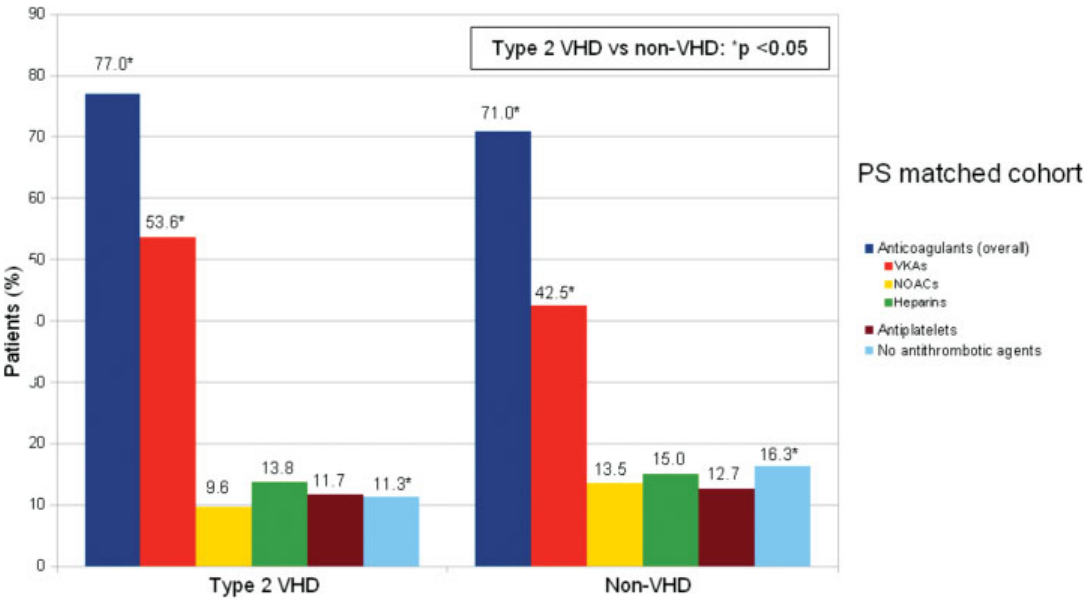
Fig. 4 Treatment distribution in type 2 VHD and in non-VHD matched patients at entry visit. PS, propensity score; VHD, valvular heart disease. Table 2 Anticoagulants use before and after the registry entry visit in the propensity-matched sample Treatment At entry At